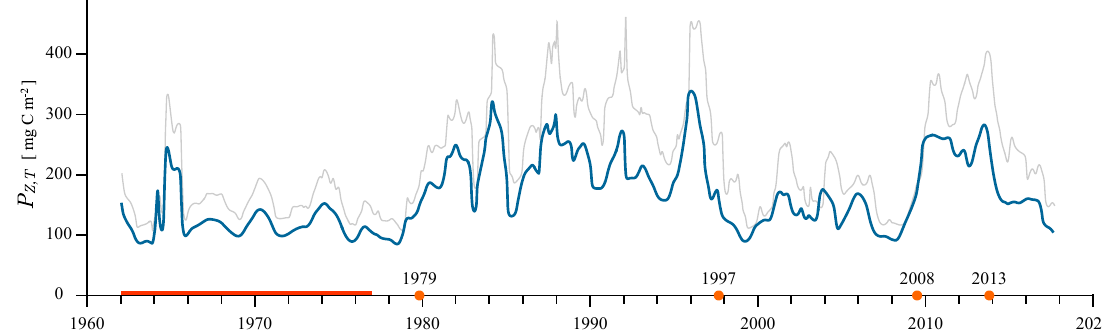
Figure 5. Annual running means of water column production from April 1962–July 2017. The original time-series, obtained by application of (9), is given in grey. The corrected time-series, obtained by application of (10), is given in thick blue. Start of each regime is indicated by an orange circle with the corresponding year above it. The red line at the beginning of the sampling era highlights the period without chlorophyll